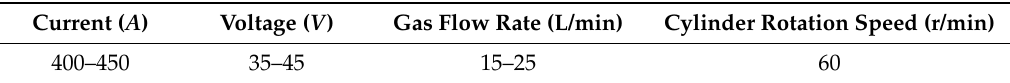
Table 2. Plasma welding operation parameters.